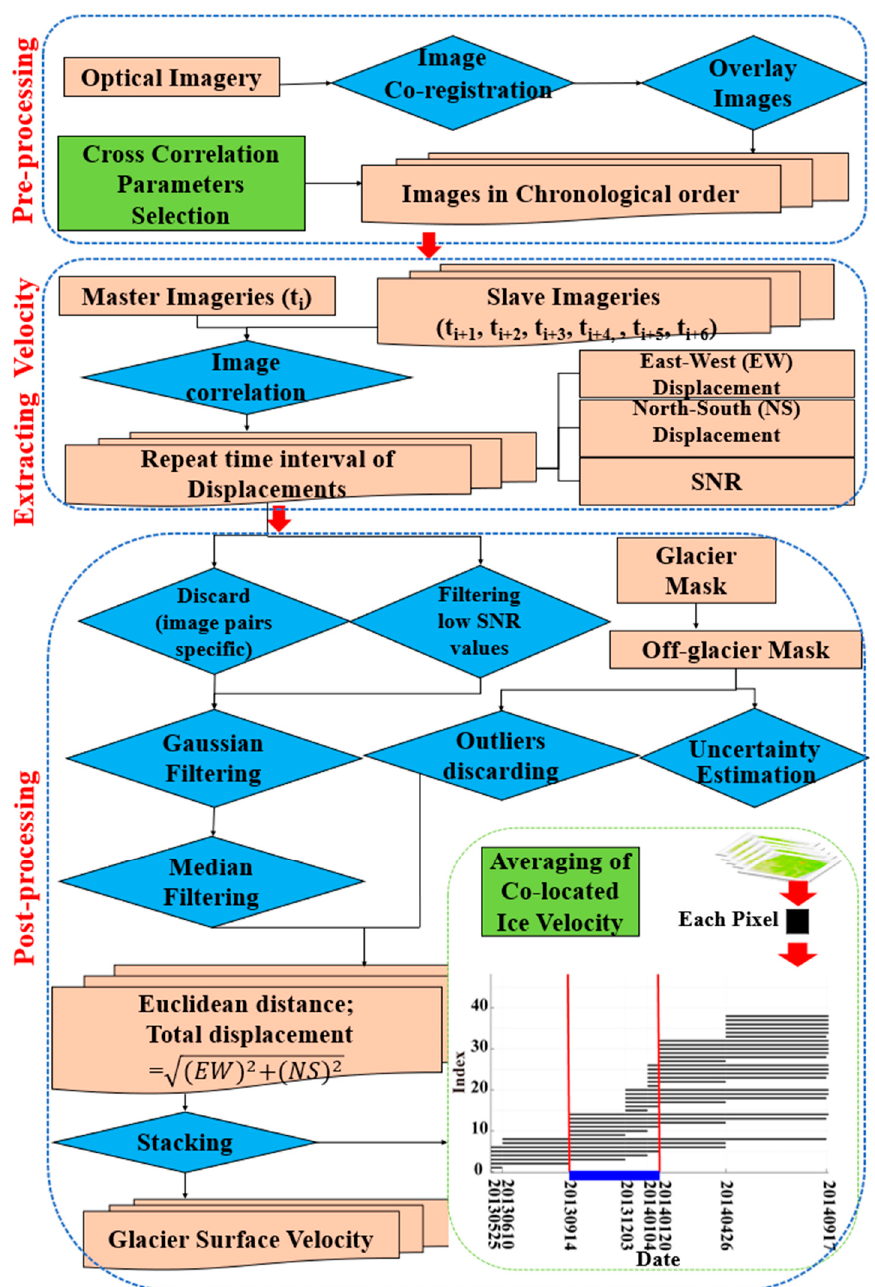
Figure 2. Flowchart of the methodology used to retrieve glacier surface velocity from Landsat image-pairs; the box “Averaging of co-located ice velocity” applies to the estimation of the stack velocity: the black lines represent image pairs having the unique index indicated on the y -axis; the dates of image acquisitions are shown on the x -axis; the blue segment under the lowest gray line indicates the temporal window applied to select the retrievals to be extracted and averaged to estimate the stack velocity.